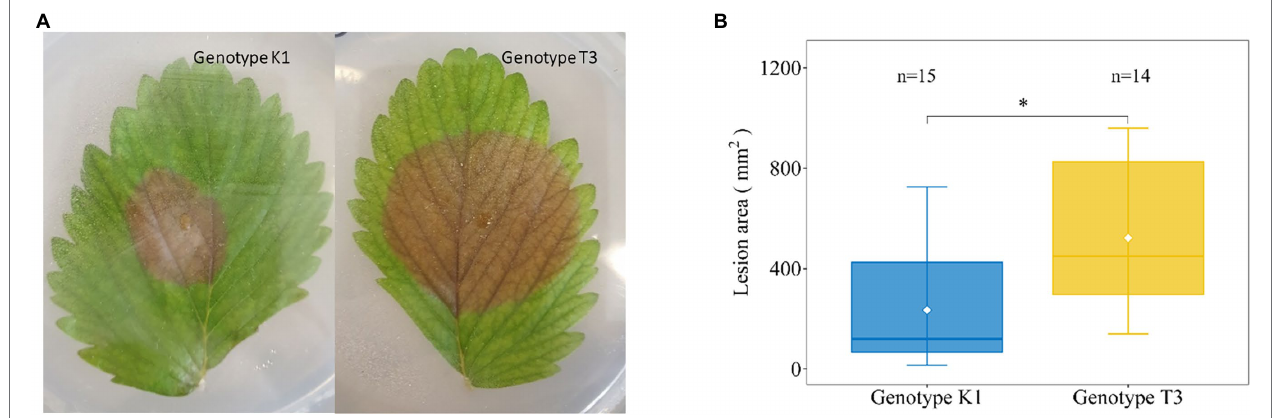
FIGURE 1 | Representative picture of disease symptoms (A) and lesion area (B) on strawberry leaves of Kreuzkogel 1 (K1) and Tenno 3 (T3) at 5 d post Botrytis cinerea inoculation. The asterisk ‘ * ’ indicates significant differences among two genotypes by Wilcox test at p < 0.05.